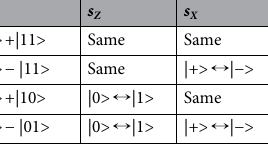
Table 1. Relation between the initial and output states regarding s Z and s X at a stabilizer